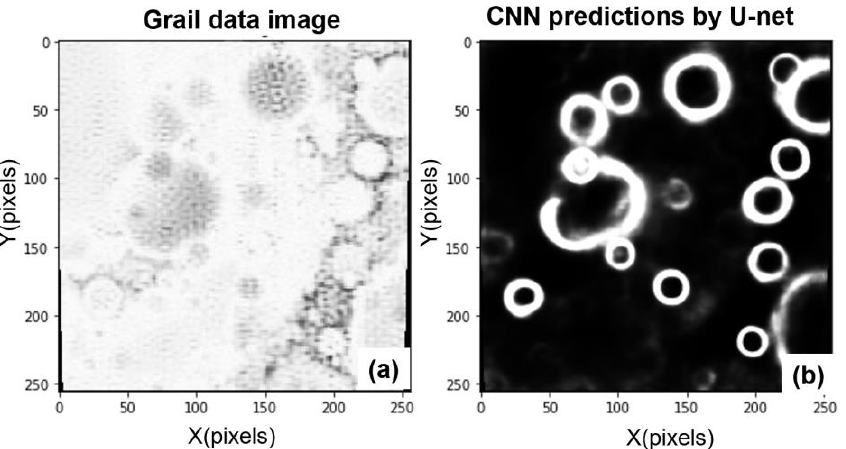
Figure 5. The comparison of the input data (( a ): GRAIL data image) and output data ( b ): CNN predictions by U-net).